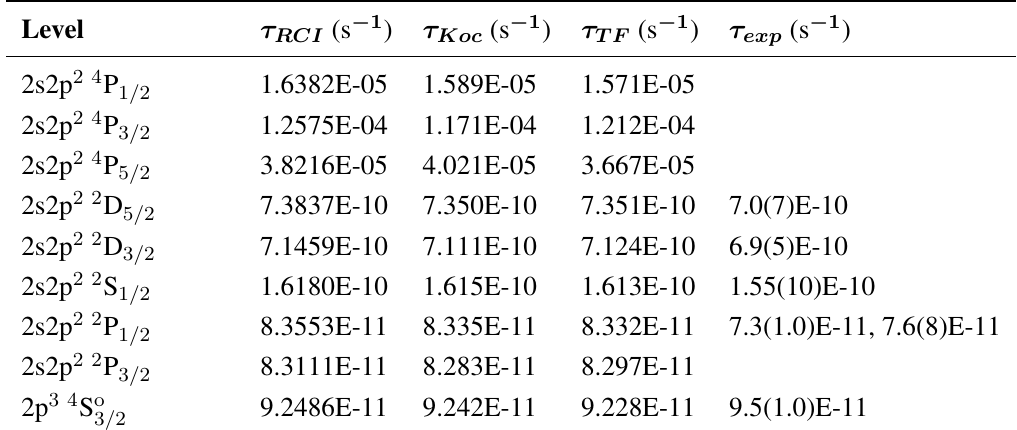
Table 2. Radiative lifetimes. τ lifetimes from present RCI calculations; τ RCI from Koc [38]; τ lifetimes from Tachiev and Froese Fischer [37]. Experimental lifetimes TB τ from beam-foil studies by Buchet et al. [17] and Tordoir et al. [26]. A table exp